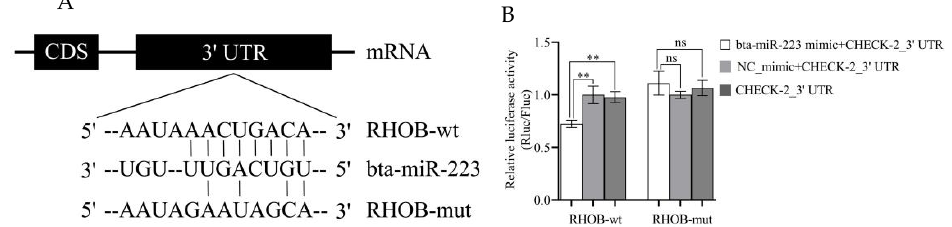
Figure 2. Bta-miR-223 directly targets the RHOB gene by binding to its 3 (cid:48) UTR. Because RHOB-wt and RHOB-mut are the experimental results of two dishes of cells, the final data were normalized. ( A ) Predicted bta-miR-223 binding sites and experimentally introduced mutations within the RHOB 3 (cid:48) UTR are shown. ( B ) Verification of the presence of the bta-miR-223 binding site in the RHOB 3 (cid:48) UTR by a dual-luciferase reporter assay. The experimental results are displayed as the mean ± SEM. ** p < 0.01, ns p > 0.05. CDS = coding Sequence; NC_mimic = negative control, compared with bta- miR-223 mimic; RHOB-wt = wild type of RHOB target site; RHOB-mut = RHOB sentinel mutation; CHECK-2_3 (cid:48) UTR = dual-luciferase reporter recombinant vectors RHOB-wt-3 (cid:48) UTR or RHOB-mut 3 (cid:48) UTR and psi-CHECK-2; Rluc/Fluc = Renilla luciferase/firefly